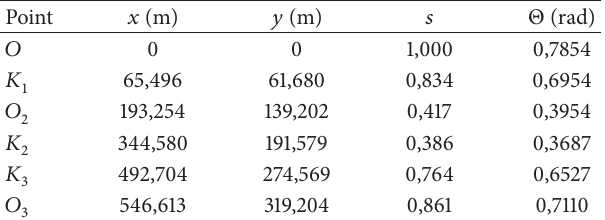
Table 2: Characteristic of the principal points of the geometric system (Example 2).